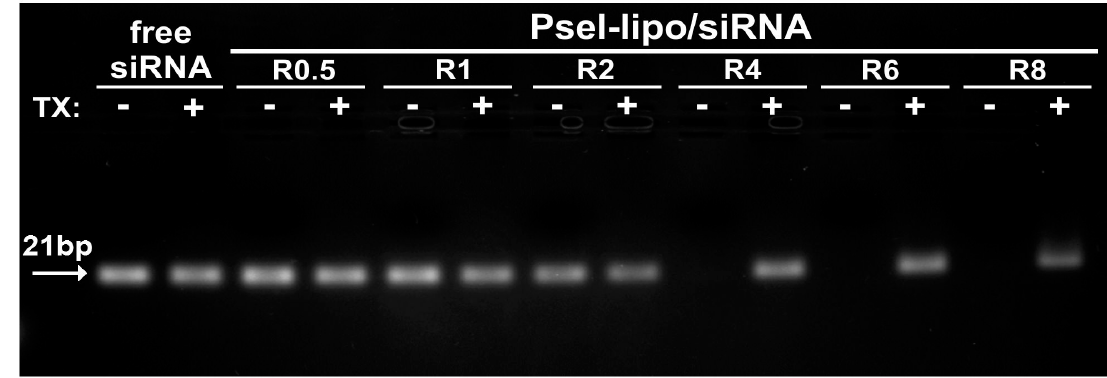
Figure 2. Agarose gel retardation assay performed for free siRNA and Psel-lipo/siRNA complexes at different charge ratios +/ − (R) (200 ng siRNA/lane), in the absence or presence of 1% Triton X-100 (TX).